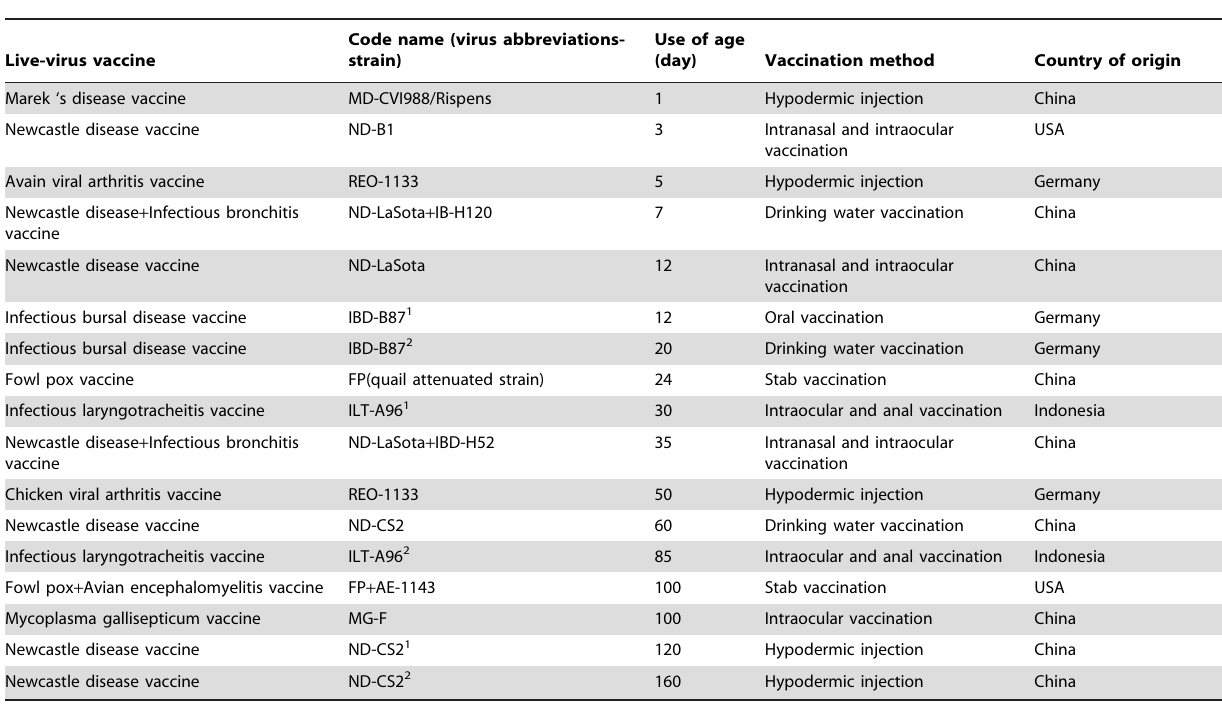
Table 2. List of vaccines used in the affected broiler breeder flocks.